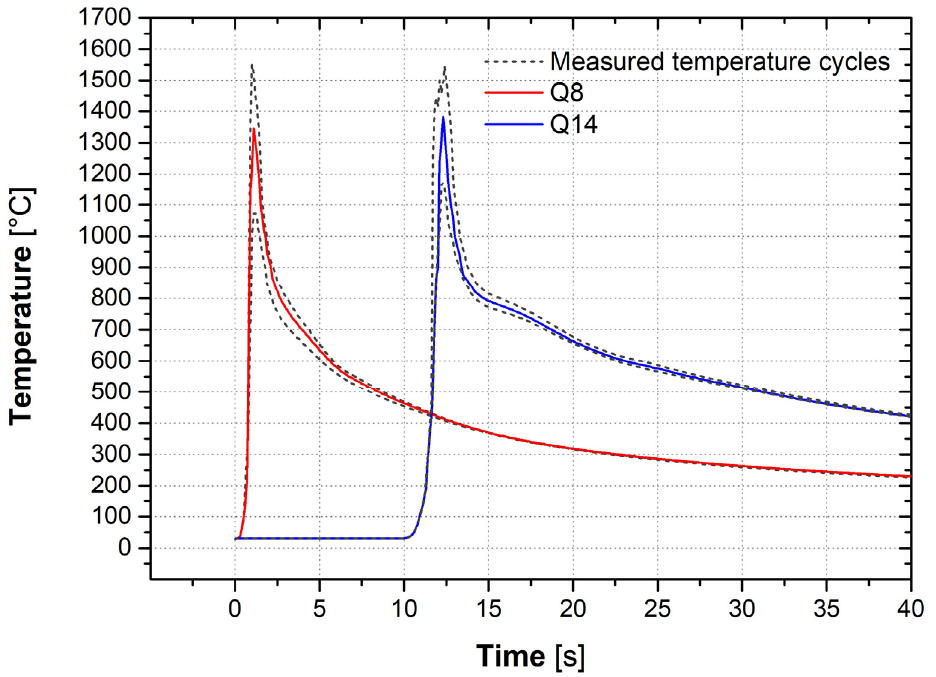
Figure 14. Temperature cycles for heat input values 8 and 14 kJ · cm − 1 (generated in such manner to match with a distance of 0.1 mm from the fusion line). Table 6. Results of grain coarsening measured by EBDS analysis.